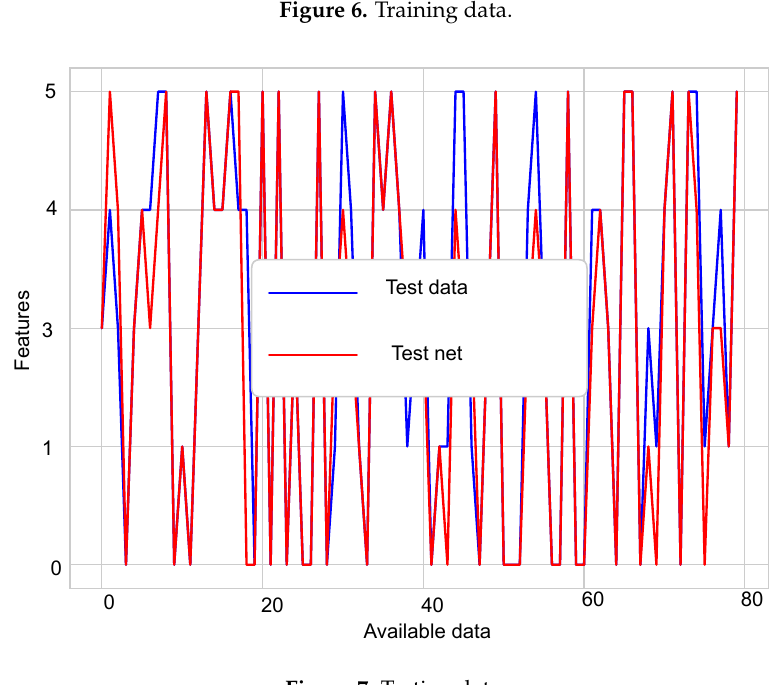
Figure 7. Testing